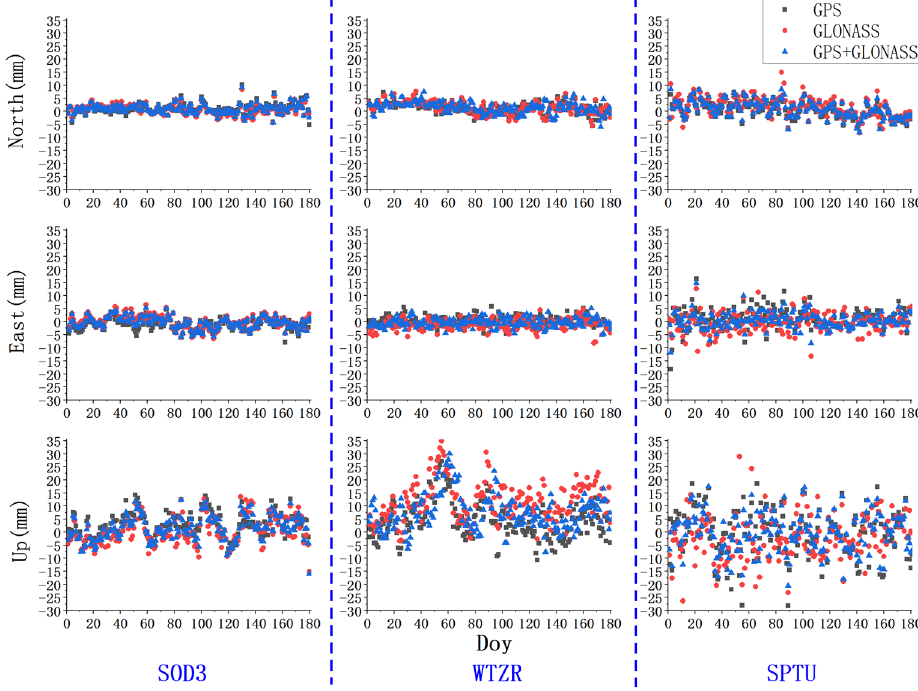
Figure 12. The coordinate error series of station SOD3, WTZR, and SPTU estimated with PPP.